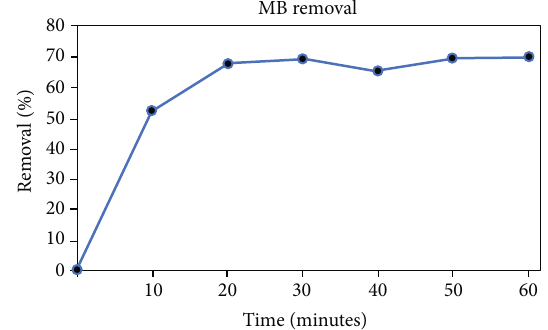
Figure 8: Percent removal of methylene blue dye by using sintered incense stick ash product as an